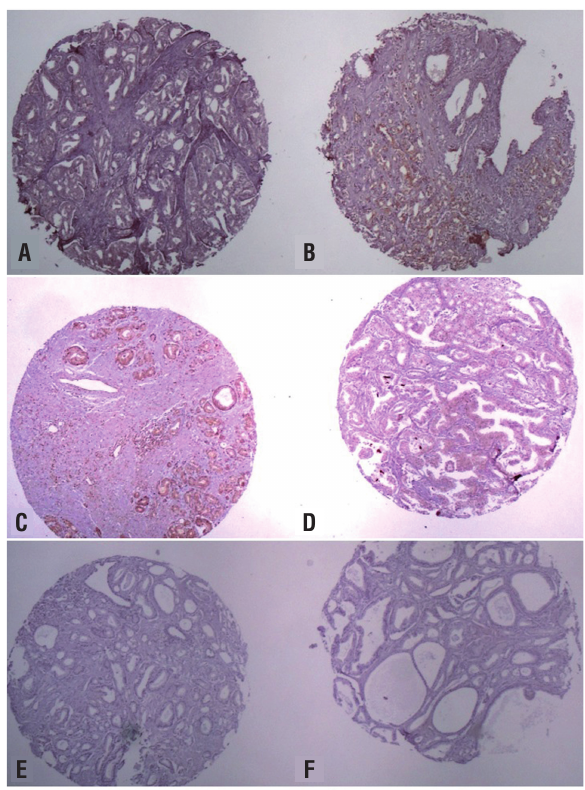
figure 2 - photomicrograph illustrating immunohistochemical reactions. A: positive reaction of MMp-14 in cancer tissue; B: negative reaction of MMp-14 in normal prostate tissue; C: positive reaction of IL-8 in prostate cancer; D: negative reaction of IL-8 in normal prostate tissue; E: negative reaction of TIMp-2 in prostate cancer; f: positive reaction in control